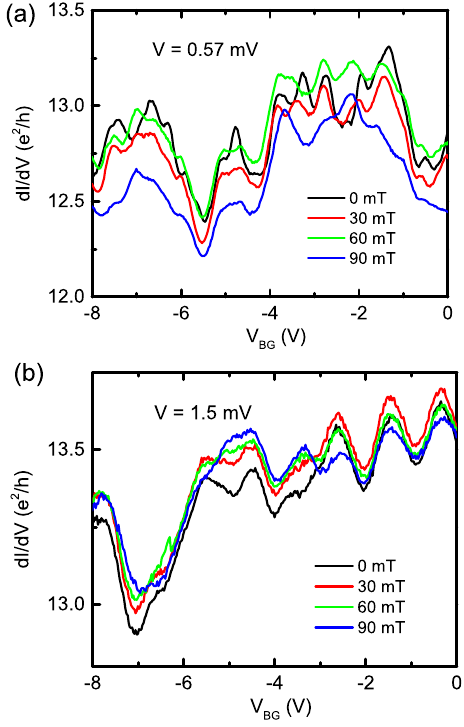
FIG. 5. Magnetic field dependence of geometric resonances for source-drain bias (a) V ¼ 0 . 35 mV and (b) V ¼ 1 . 5